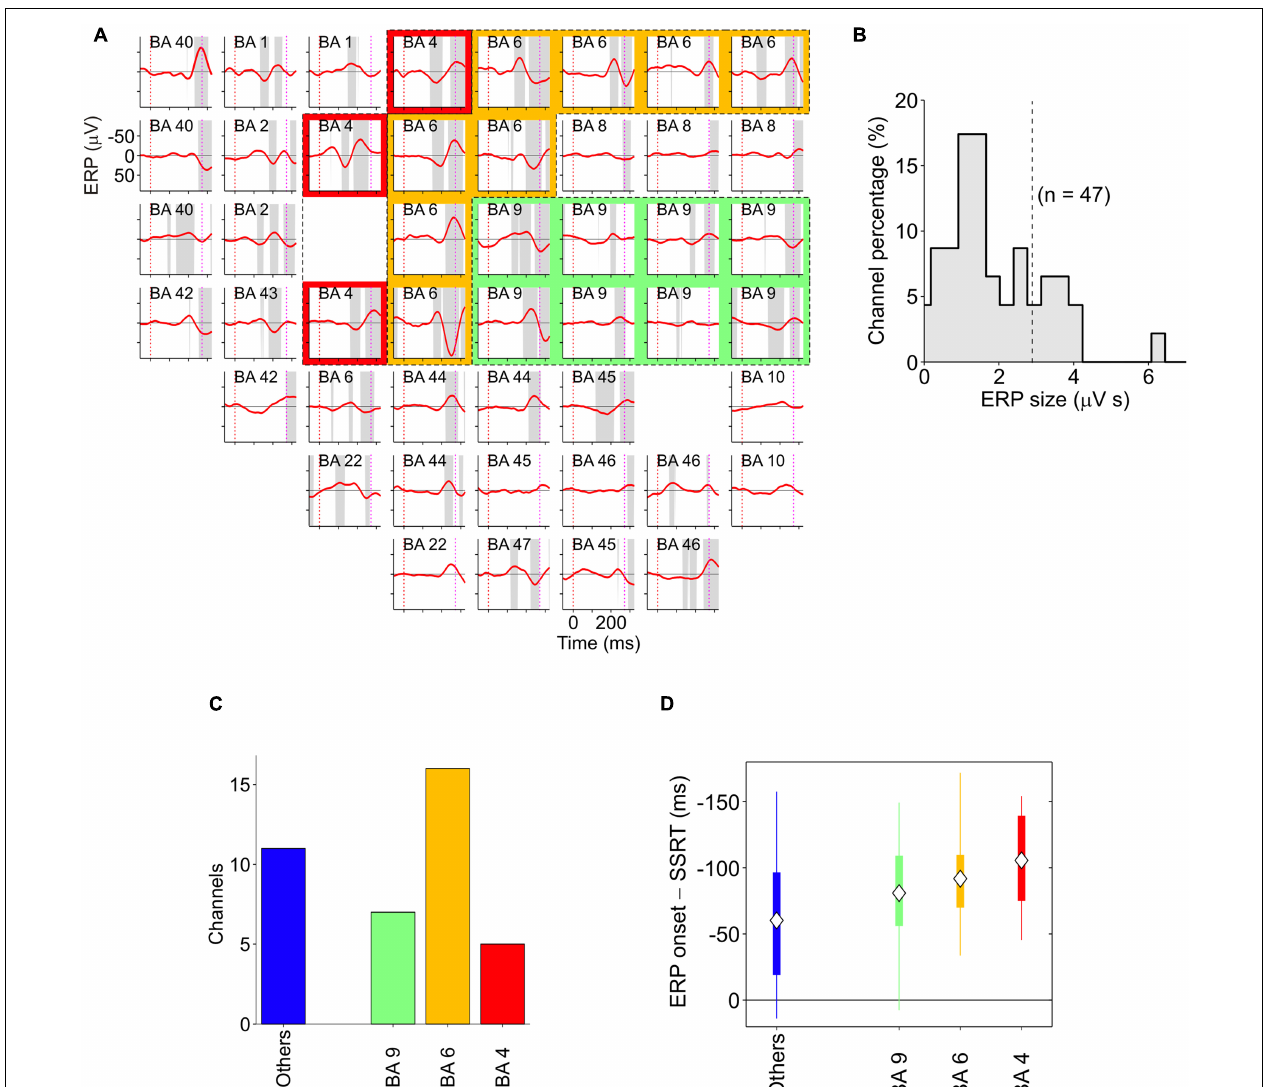
FIGURE 7 | Spatiotemporal distribution of stop-event related potentials (ERPs) in successful-stop (SS) trials. (A) Average stop-ERPs (solid red curves) of SS trials centered on stop-signal appearance corresponding to the selected channels for one pharmacoresistant epileptic patient. Gray areas, time intervals at which the stop-ERP was significantly different from 0 (Wilcoxon signed-rank test, P < 0.01). Subplot labels: Brodmann areas (BAs) over which electrodes were positioned. Colored areas: electrodes placed over the primary motor cortex (red, BA4), the premotor cortex (yellow, BA6) and the DLPFC (green, BA9). (B) Histogram of the stop-ERP sizes of panel (A) . Stop-ERP sizes were computed as the integral of absolute values of stop-ERP voltage deflections in the interval periods marked by gray areas within SSRT.